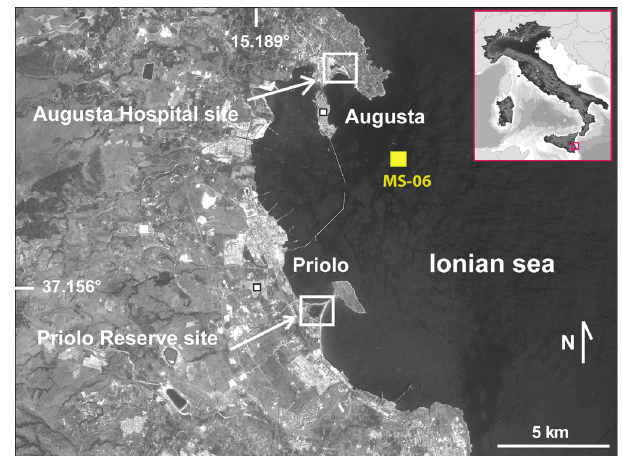
Fig. 1. Location of the Augusta Bay in eastern Sicily, Italy. The Augusta Hospital and Priolo Reserve sites are marked with white empty rectangles, while a yellow box locates the offshore coring site (MS-06). The small white filled squares indicate the Augusta and Priolo